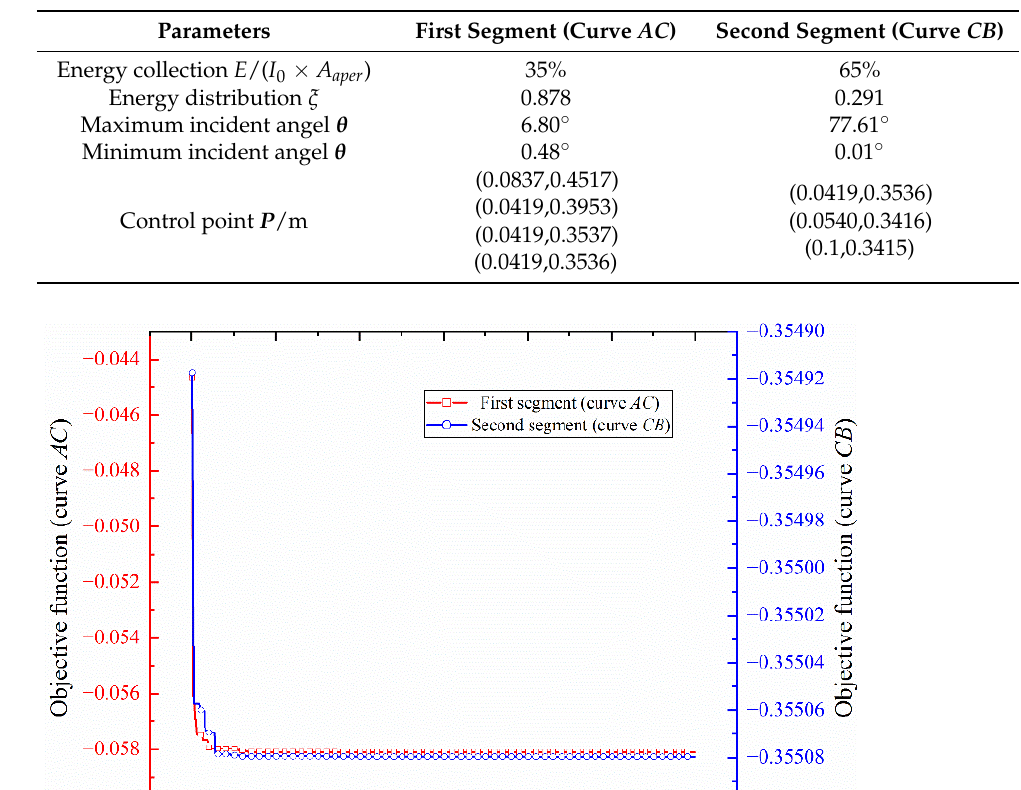
Table 1. Detailed parameters of optimal design.